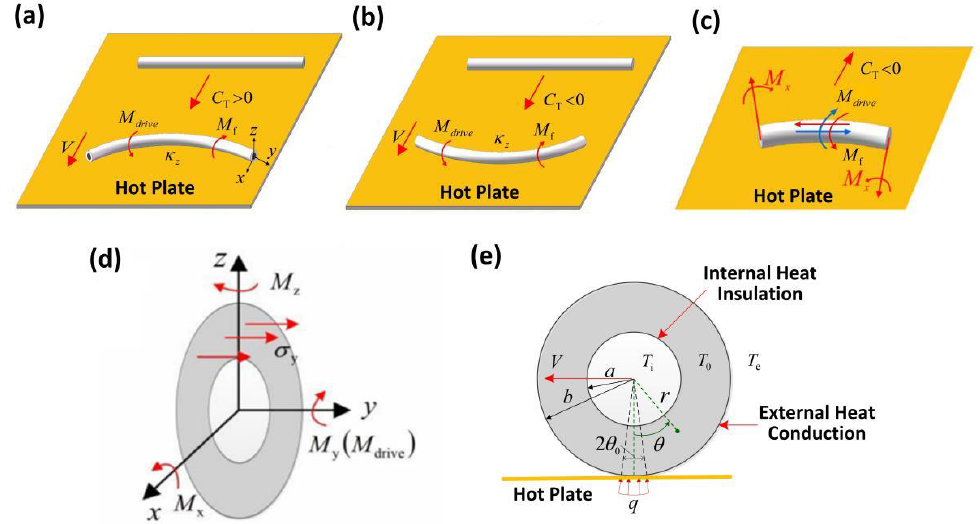
Figure 1. Schematic of a thermally driven rolling thick-walled cylindrical rod on a hot plate. ( a ) For thermal expansion materials, the thermal expansion coefficient C T is positive, and the rod rolls in a concave direction. ( b ) For thermal shrinkage materials, the thermal expansion coefficient C T is negative, and the rod rolls in a convex direction. ( c ) The driving moment applied to the thick-walled cylindrical rod and the friction moment acting on the rod. ( d ) The stresses on the cross-section of the thick-walled cylindrical rod and the moments in all directions. ( e ) The cross-section of the thick-walled cylindrical rod. Considering that the length of the rod is much greater than its thickness, we assume that the temperature distribution in the rod cross-section remains the same throughout the length of the rod. An inhomogeneous temperature field in the rod cross-section leads to uniform thermal expansion/shrinkage, which generates a driving moment M drive that equilibrates with the friction moment M f and causes the thick-walled cylindrical rod to self-roll.